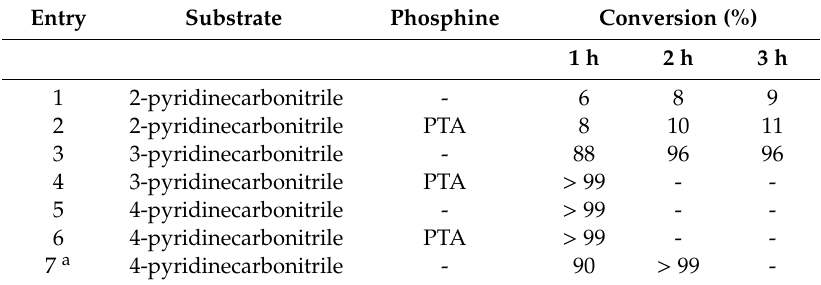
Table 8. Hydration of substituted pyridinecarbonitriles with catalyst 1 in the absence of added